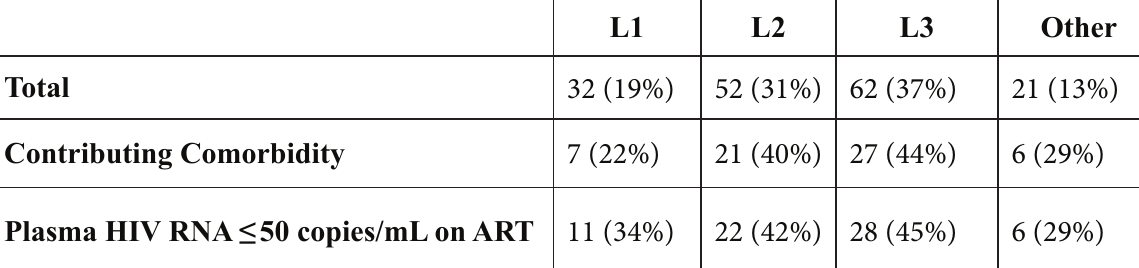
Supplementary Table 3. Distributions of the populations for the secondary analyses in the par- ticipants of African ancestry, broken out by major haplogroups L1, L2, and